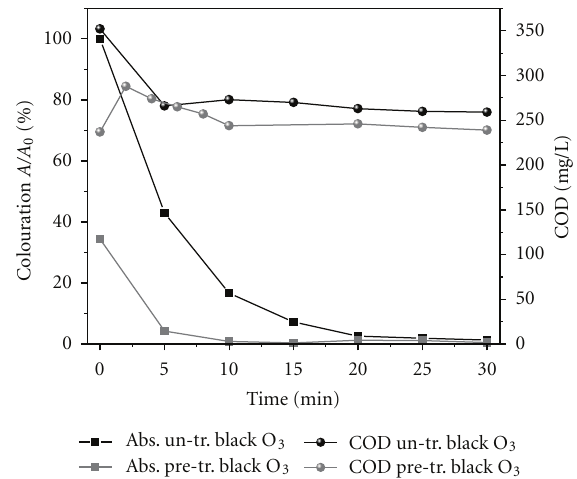
Figure 10: Colouration expressed as A/A 0 and COD values of Reactive Black 5 wastewater samples at di ff erent times of PCOz